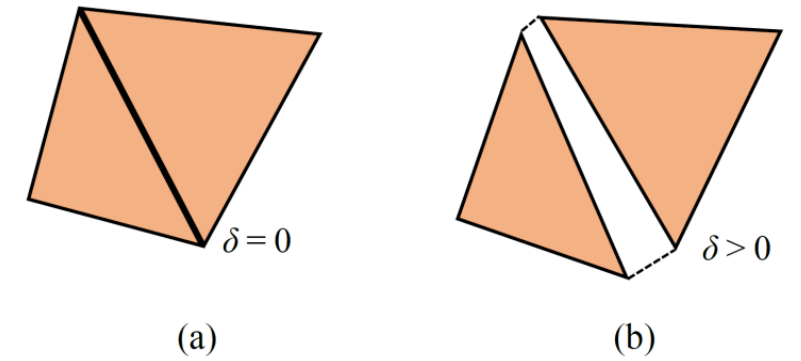
Figure 2. Joint element: ( a ) before deformation; ( b ) after